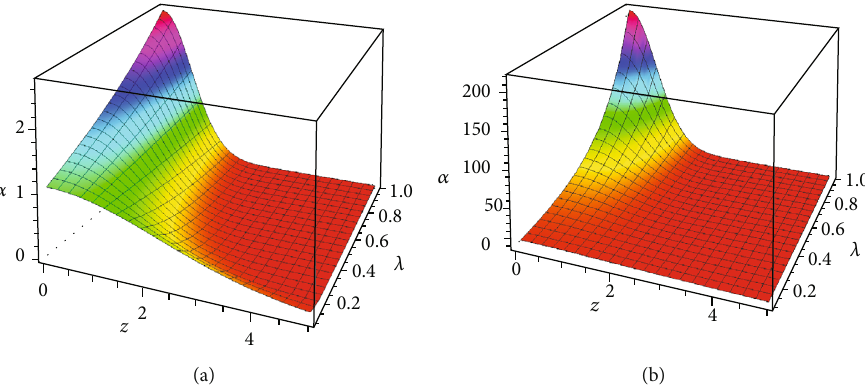
Figure 2: Considering pair production parameters versus each other in a 3D plot, at zero temperature and fi xed value of probe brane position at (a) z = 1 and (b) z = 2 0 0